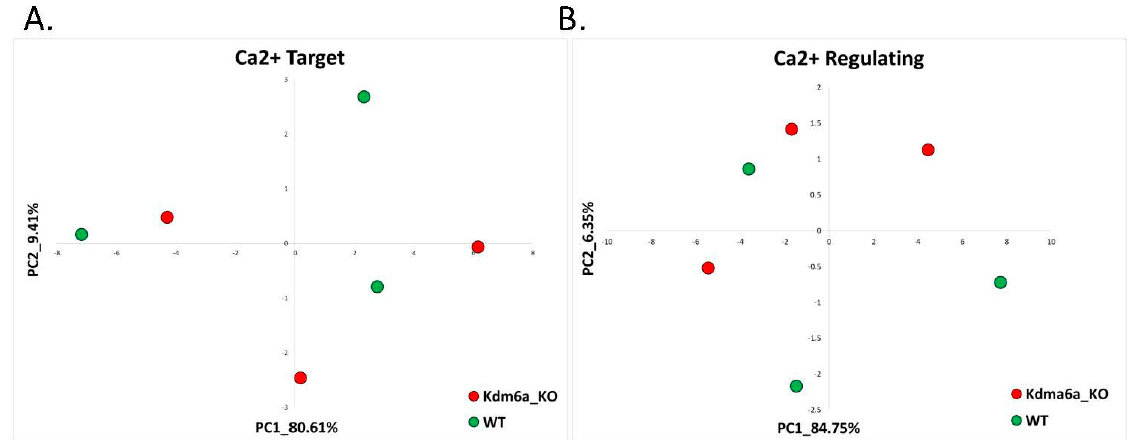
Figure 8. Kabuki Syndrome: calcium-target and calcium-regulating signatures. ( A ) PCA based on the expression of calcium-target signature genes in brain tissue of neuron-specific Kdm6a-deficient mice and their WT controls. The control samples are denoted in green, while the Kdm6a-KO samples are in red. ( B ) PCA based on the expression of calcium-regulating signature genes in brain tissue of neuron-specific Kdm6a-deficient mice and their WT controls. The control samples are denoted in green, while the Kdm6a-KO samples are in red. Differential gene expression analysis revealed no differentially expressed genes in this Kabuki mouse model. Nonetheless, when the threshold of significance was reduced to include only adjusted p -values < 0.01 (without any threshold of fold change), the analysis of differentially expressed genes showed that ‘Calcium’ and ‘Calcium-dependent membrane-targeting’ GO terms were significantly enriched (Supplementary Figure S6A,B).